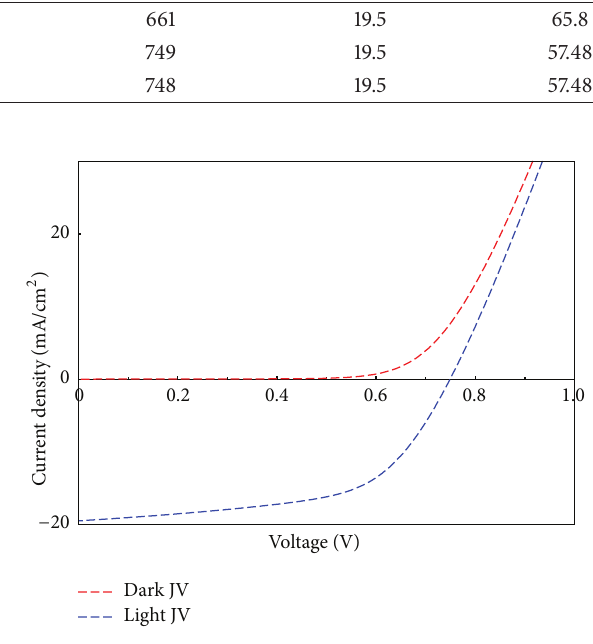
Figure 2: Band diagram obtained from our CZTSsolar cell baseline.